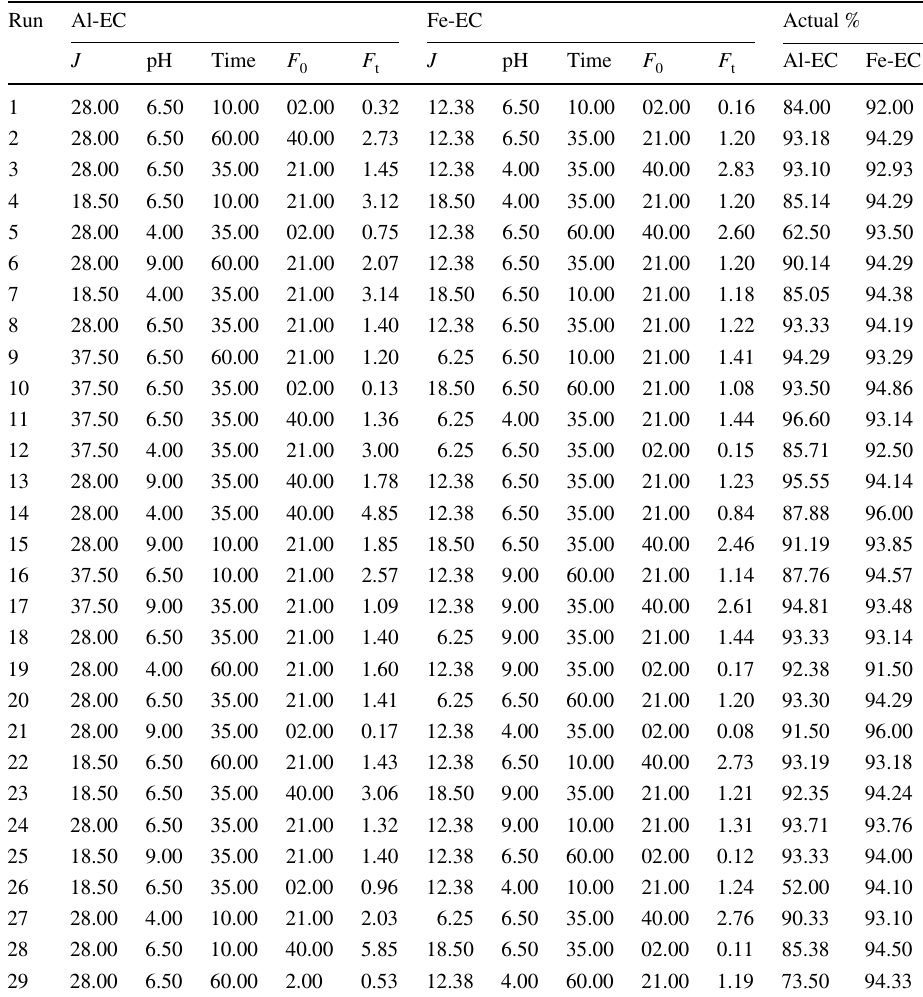
Table 2 The Box–Behnken design (BBD) showing actual and predicted fluoride reduction for Al-EC and Fe-EC reactor at different operation